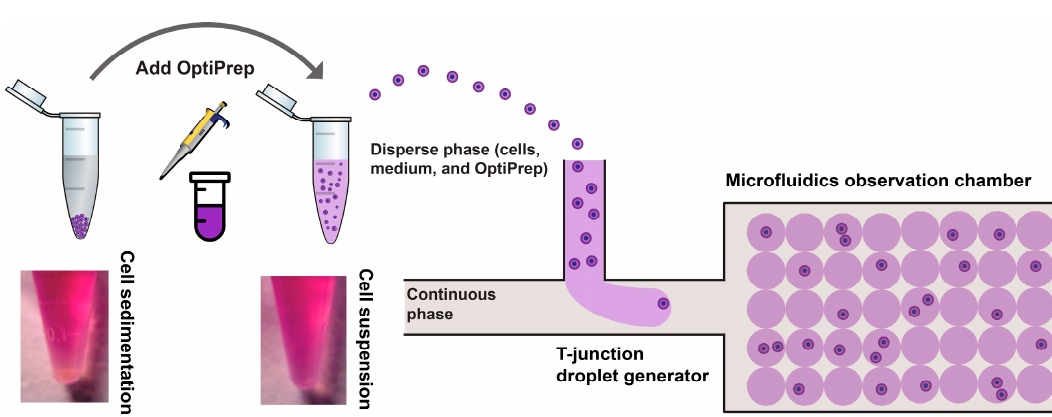
Figure 1. The two immiscible fluids (continuous phase: oil; dispersed phase: cell, medium, and OptiPrep TM ) were simultaneously infused into the droplet generation part, a T-junction, of the fabricated microfluidic chip. The formation of droplets took place when shear force acting on the interface between two fluids overcame the interfacial force (shown in Video S1). Cells were encapsulated into microdroplets containing aqueous solutions surrounded by the oil phase.